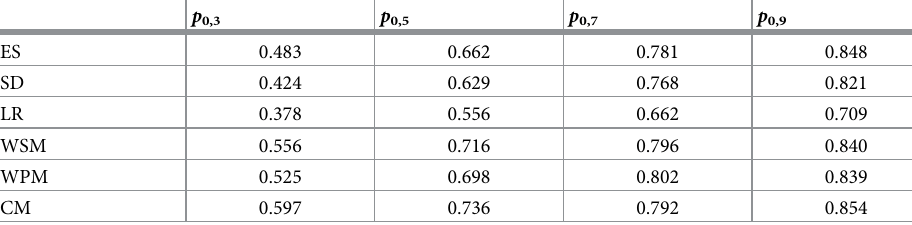
Table 2. The accumulative accuracy rate of the competition model and five contrast